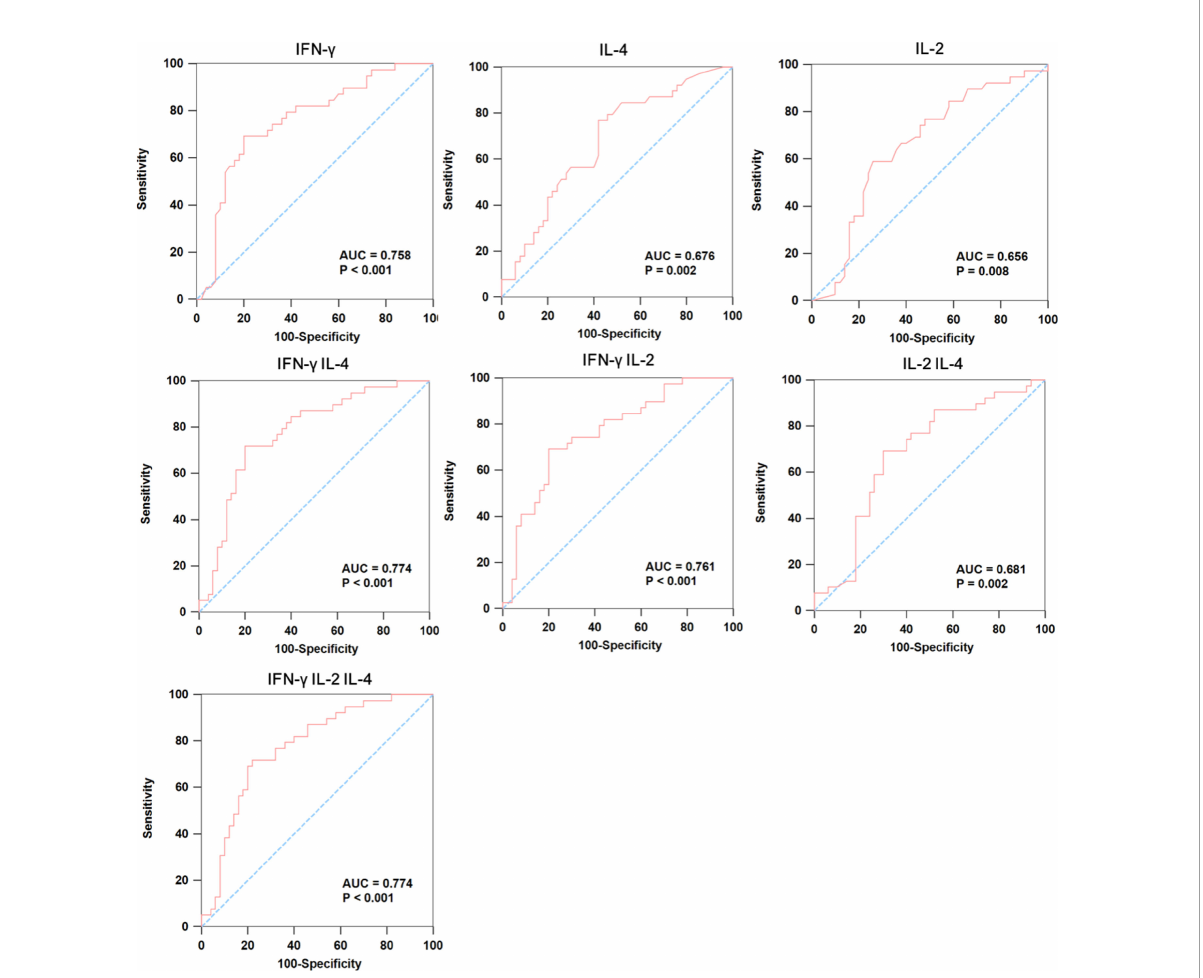
FIGURE 3 The ROC curve analysis of cytokines between IGRA-negative TB patients and healthy controls. We used ROC curve analysis to detect whether the combination of multiple cytokines could be used as promising markers for differentiating IGRA-negative group (n=50) from healthy controls (n=39), where the AUC was calculated to evaluate the severity and prognostic accuracy of each